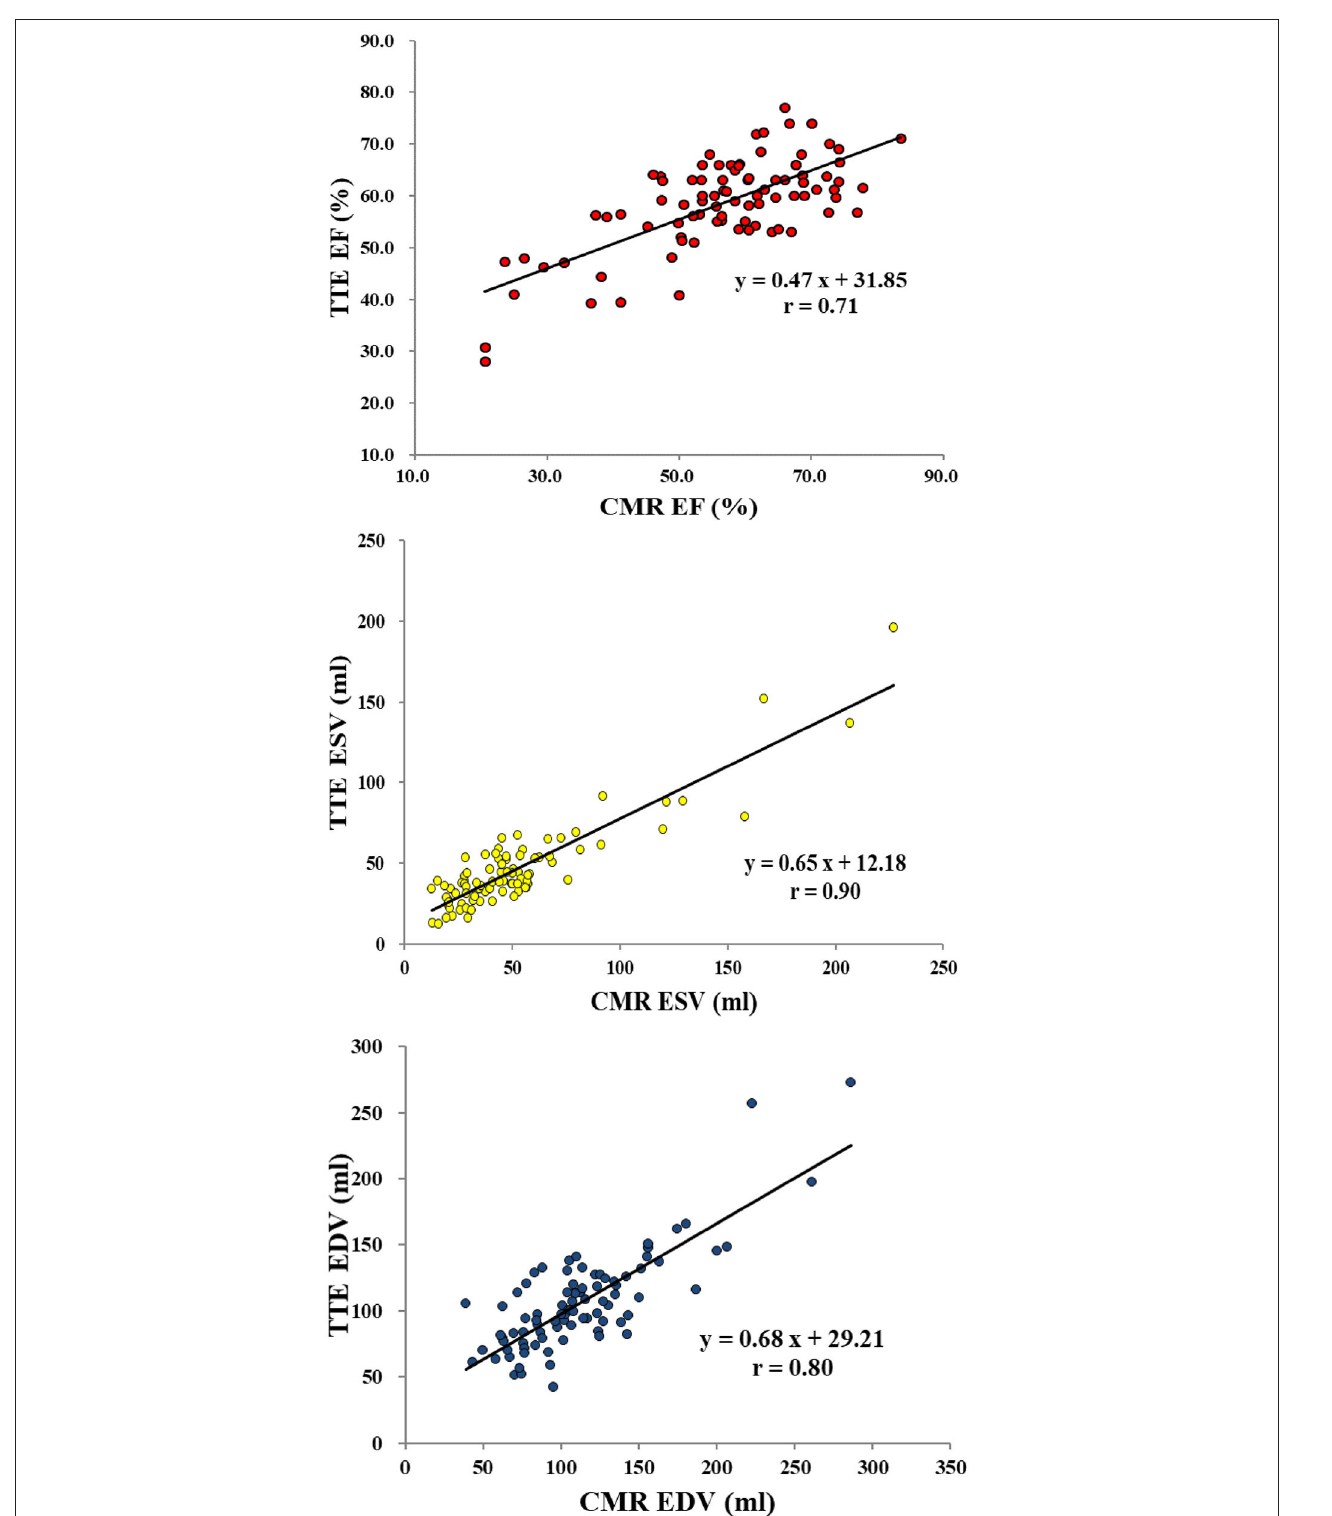
FIGURE 2 | Linear regression analysis for left ventricular functions between echocardiography and CMR (reference standard). EF, ejection fraction; ESV, end-systolic volume; EDV, end-diastolic volume; CMR, cardiovascular magnetic resonance; TTE, transthoracic echocardiography.